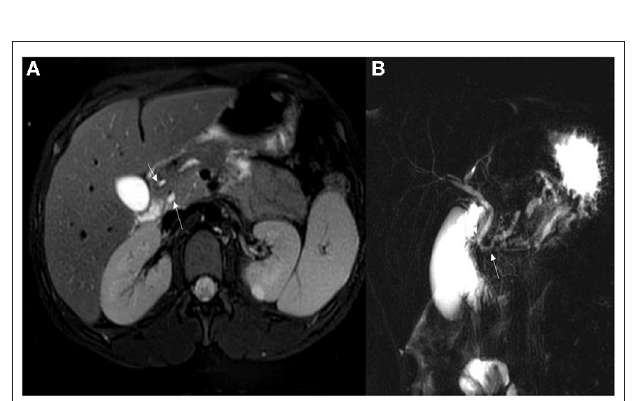
FIGURE 2 | (A) Axial T2 WI’s with fat sat demonstrating pancreatic divisum with the main pancreatic duct seen entering separately into the minor papillae (upper arrow). The lower arrow is the common bile duct seen entering into the ampulla of vater. (B) MRCP demonstrating pancreas divisum with the main pancreatic duct (lower arrow) open separate from the common bile duct (upper